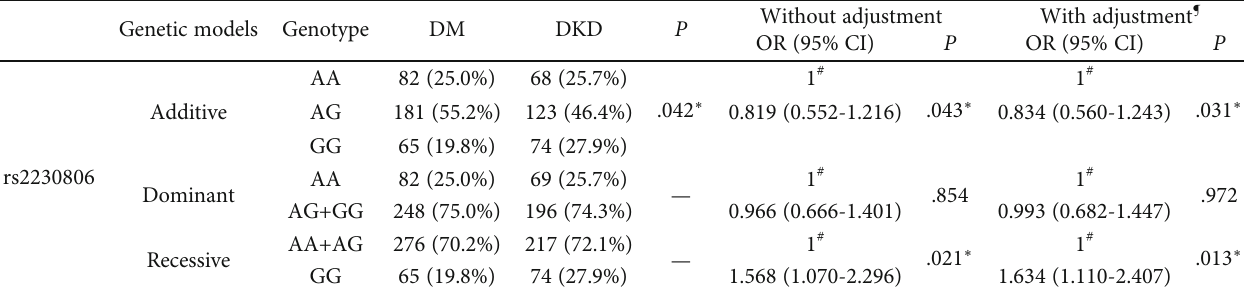
Table 5: Genetic model analyses of the association between SNP rs2230806 and DKD patients without hypercholesterolemia with adjustment for age and